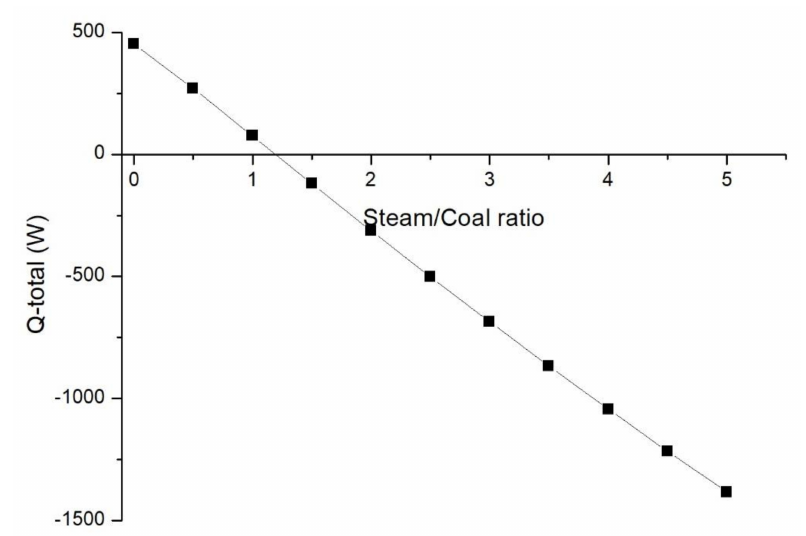
Figure 15. The e ff ect of S / C on the simulation system heat